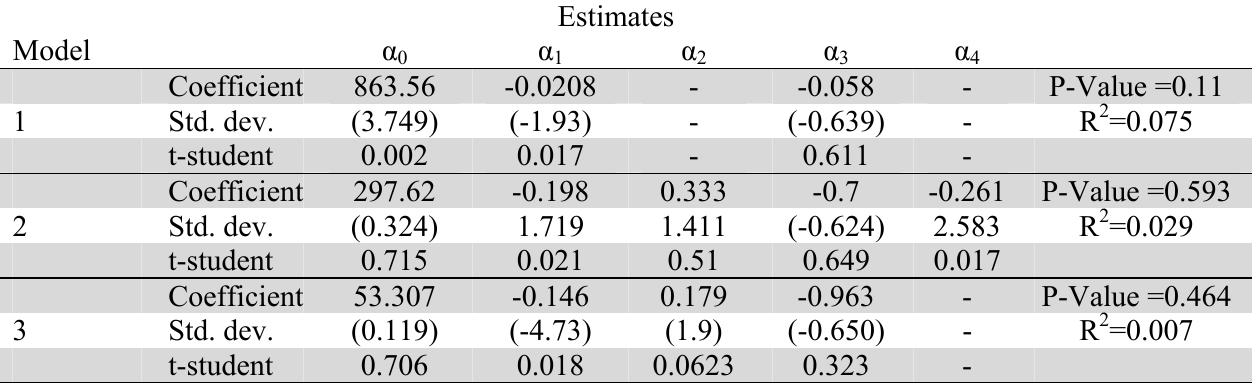
The summary of stepwise regression analysis